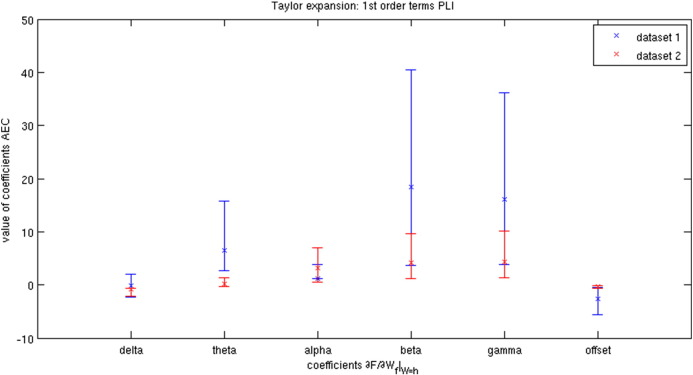
Estimated parameters (Taylor coefficients) for analysis level 1 using model d, linear + non-linear approximation based on all MEG frequency bands using the AEC as functional connectivity metric for MEG. Note that the confidence intervals of the estimated Taylor coefficients for the two datasets largely overlap.